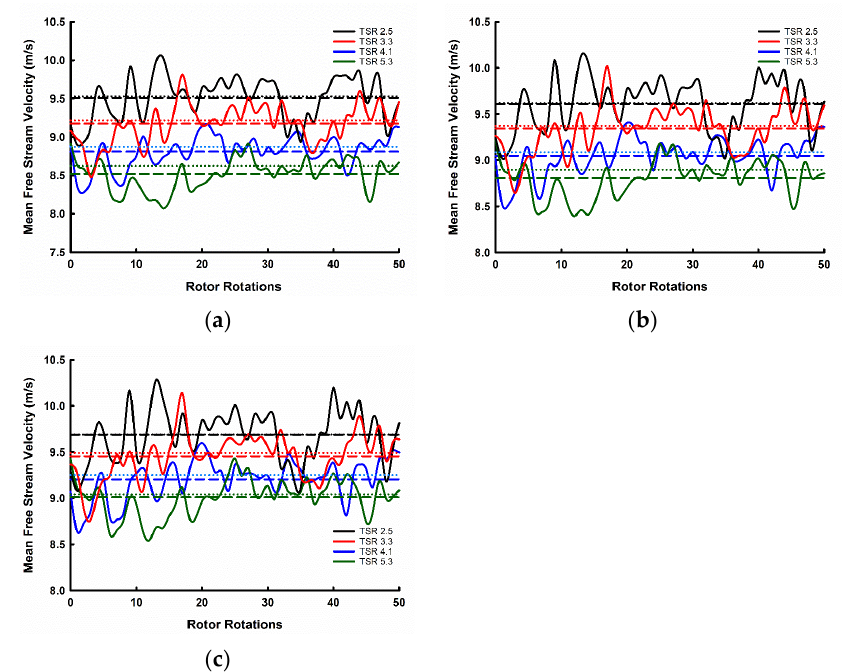
Figure 11. Effect of tip speed ratio on the average wind velocity upstream of VAWT. ( a ) 0.75 d; ( b ) 1 d; ( c ) 1.25 d. The mean and minimum-maximum is represented in the graph with the help of dashed lines and dotted lines respectively The dotted line in Figure 11a represents the uniform velocity condition, and the dashed line represents the mean of randomised velocity condition. The mean of random- ised velocity is of similar value to the magnitude of uniform velocity. The mean of ran- domised velocity for λ = 2.5 is 9.48 m/s and 9.53 m/s for the uniform velocity case. The fluctuation of inlet velocity is also taken at 1 d upwind of the turbine and 1.25 d upwind of the turbine averaged over a width 1.5 d (Figure 11b). The velocity fluctuations follow a similar variation for all tip speed ratios at the three upwind locations. As the distance from the turbine decreases, the mean of randomised velocity also decreases. The mean of ran- domised velocity for λ = 2.5 is 9.69 m/s at 1.25 d, 9.62 m/s at 1 d, and 9.53 m/s at 0.75 d. Figure 12 shows the effect of tip speed ratio on the coefficient of power of the VAWT. In general, the C p value gradually increases until a particular tip speed ratio and then steadily decreases. The C p of uniform flow steadily increases to a maximum of 0.399 at λ = 4.1, then decreases for higher tip speed ratios. The randomised wind C p follows the same trend and increases up to a maximum value of 0.401 at λ = 4.1. The C p values at λ = 3.3 and 4.1 are comparable in both wind cases. At λ = 2.5, C p = 0.160 for randomised wind and C p = 0.113 for uniform wind. There is also a considerable difference at λ = 5.3: C p = 0.283 for randomised wind, and C p = 0.324 for uniform wind. This difference in C p value between randomised and uniform wind, at higher C p and lower C p tip speed ratio, is due to the steep C p -λ slope. Figure 12. Effect of tip speed ratio on Coefficient of Performance (C p ) with random wind conditions.